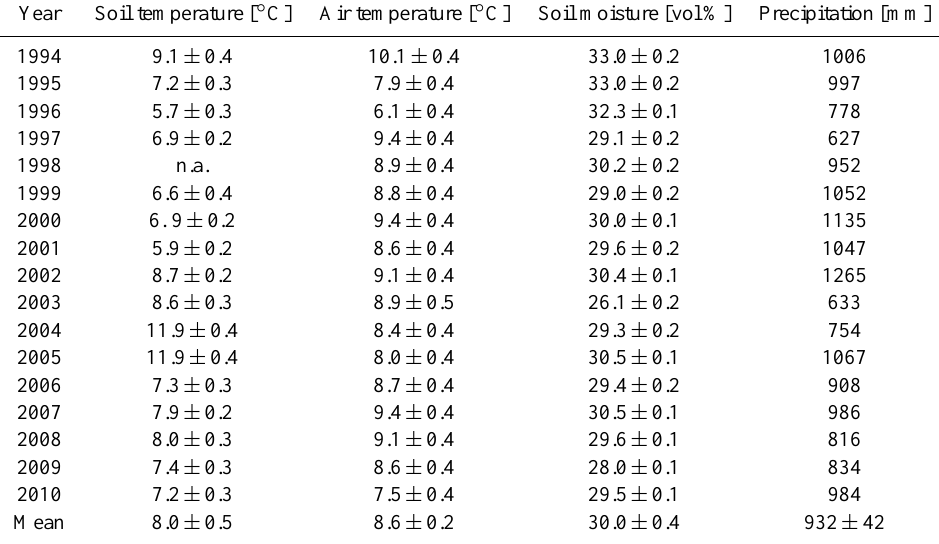
Table 1. Annual means ( ± SE) of soil temperature (5cm depth), air temperature, soil moisture (10cm depth), and cumulative precipitation.